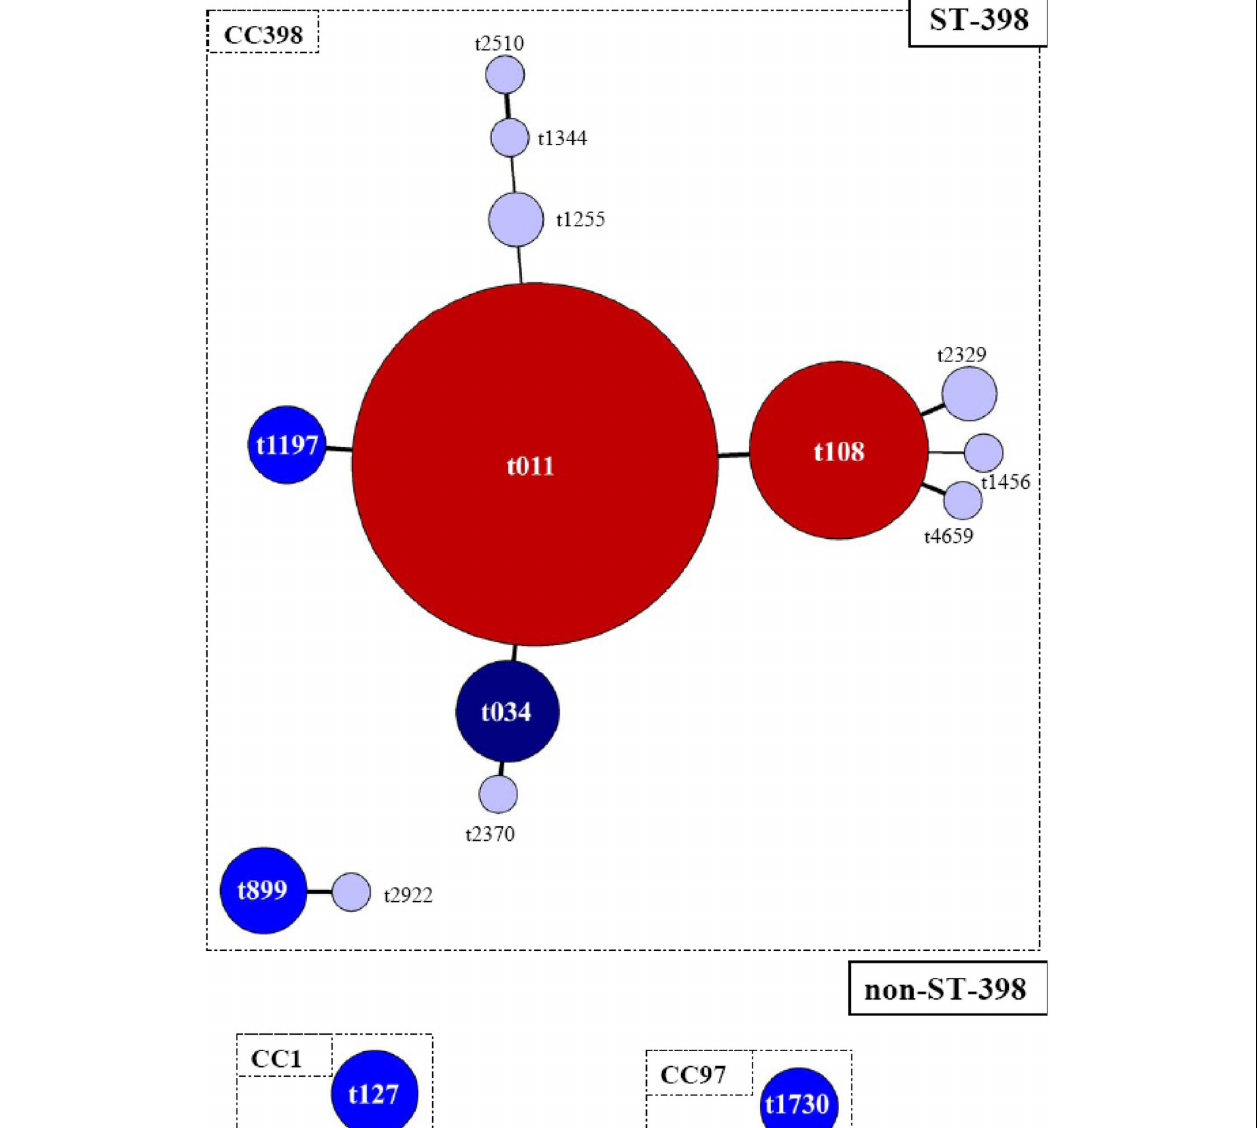
FIGURE 1 | spa types of MRSA isolated from pig production holdings in Europe, their genetic relationship , and association with ST398 and with less frequent CCs. Size and color of each circle correspond to the prevalence